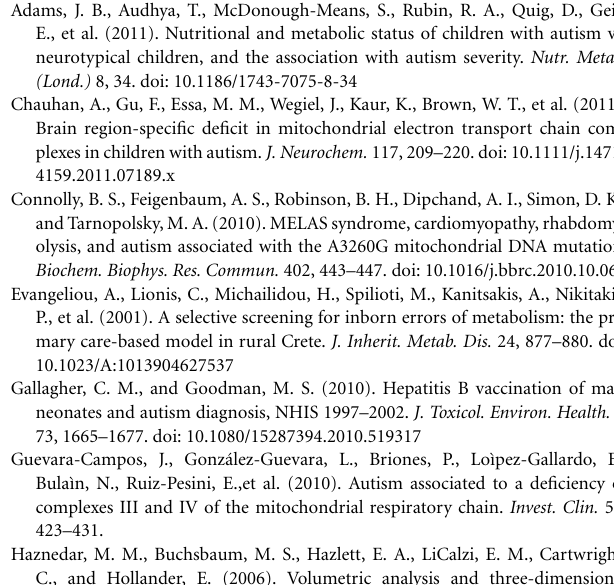
prevalence of various IEMs will be quite different. Other inves- tigators have recommended that care be taken in considering screening for IEM in ASD patients (Wang et al., 2010), and Moss and Howlin (2009) have appropriately cautioned that correla- tion of behavioral similarities between ASD and those observed in genetically-determined syndromes (e.g., Fragile X, Angelman, etc.) be carefully interpreted. Nonetheless, our report suggests that further consideration be given to the selected analysis of IEM in ASD patients, and that those studies might benefit from the broadest coverage of ethnic and regional groups possible, especially in populations for whom recessive disorders have an increased incidence. Broad screening evaluations such as these might be justifiable in helping to identify genetic subsets of ASD, providing genetic counseling opportunities for affected families, and presenting treatment options for those disorders for which therapeutic options are available. Clearly, the key outcome of our investigation is the identification of biomarker (3-OH-IVA and b-OH-b) with therapeutic relevance (biotin, KD) for patients with ASD, suggesting that our results should be investigated in additional ASD